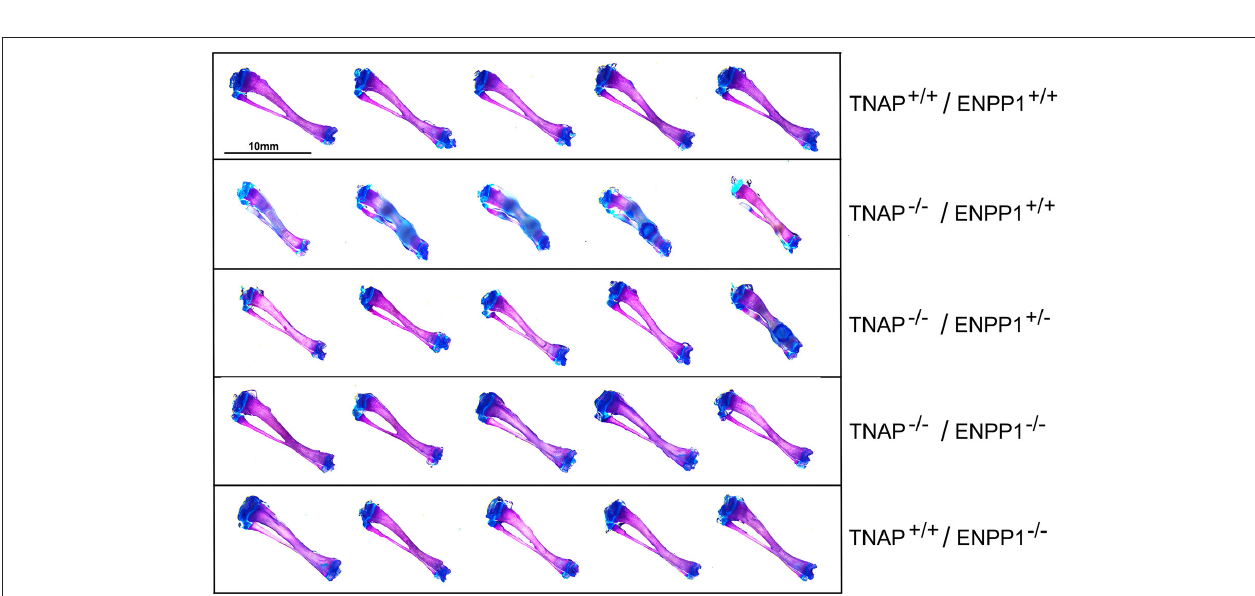
FIGURE 5 | Long bone phenotype is rescued by ablation of ENPP in TNAP deficient mice. Tibias stained with alizarin red and alcian blue of 17-day mice are shown. Severe hypomineralization is variably seen in the TNAP null mice. Double null mice appear more similar to wild type mice than TNAP null mice.